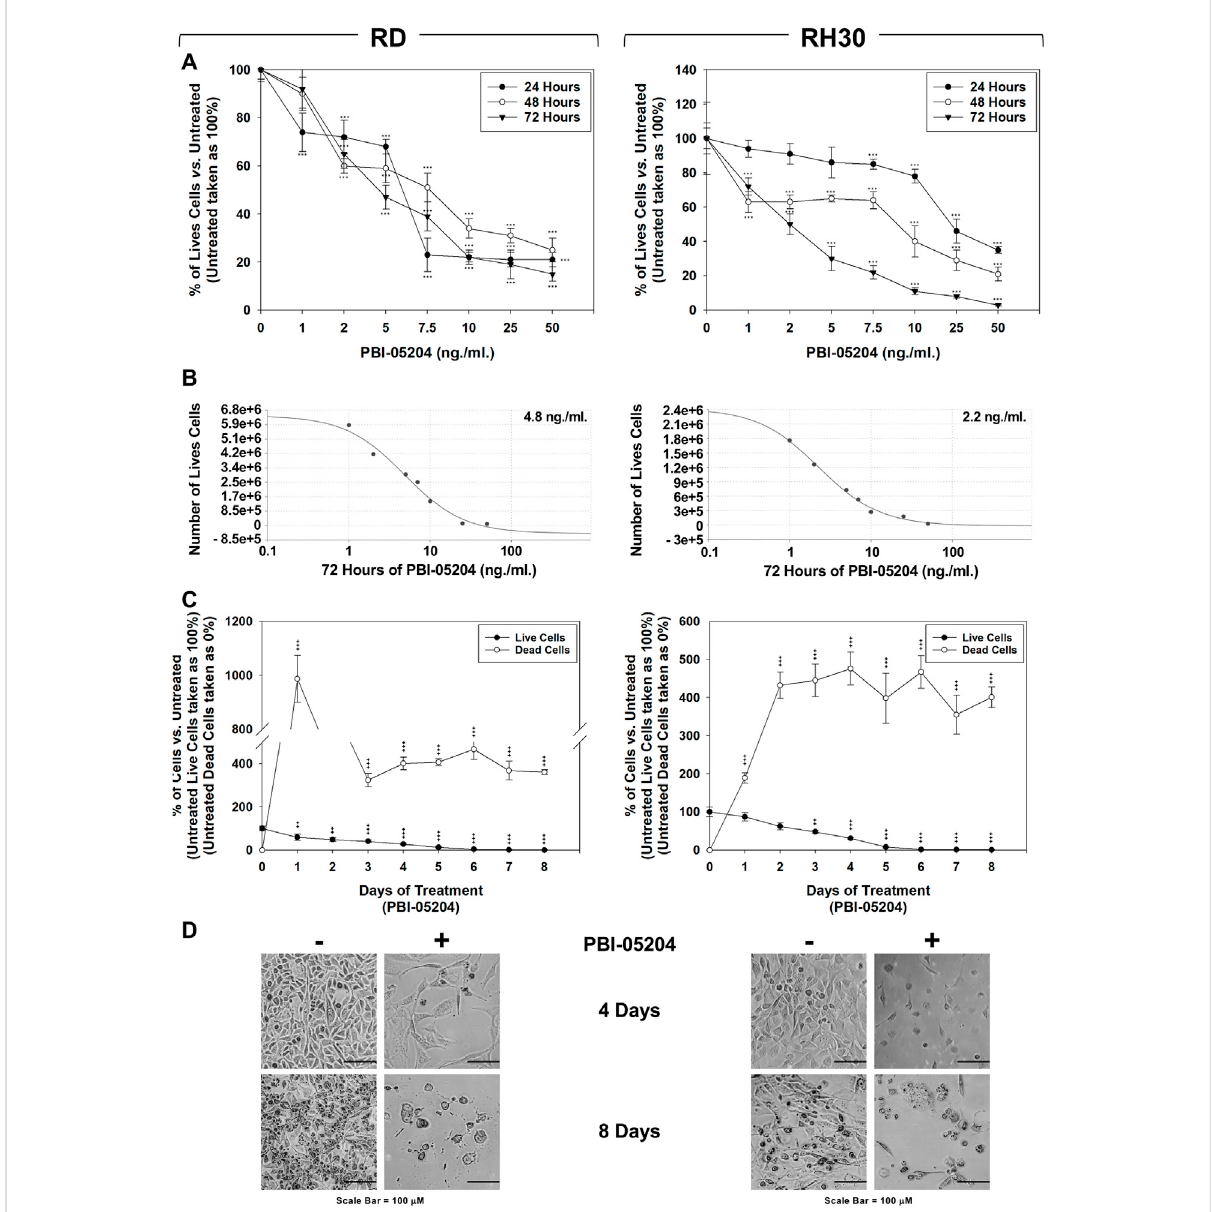
FIGURE 1 PBI-05204inducesconcomitantcelldeathandgrowtharrestinFN-RMSandFP-RMScells.RD(Left)andRH30(Right)celllinesweretreatedfor 24, 48 and 72 h with increasing concentrations (0, 1, 2, 5, 7.5, 10, 25, 50 ng/ml) of the drug. Surviving (A) cells were counted using Trypan blue dye exclusiontest. (B) ConcentrationofPBI-05204abletoreduceby50%thecellsurvivalofRD(Left)andRH30(Right)celllines. (C) EffectofPBI-05204 IC 50 on cell number oflive and dead RD (Left) and RH30 (Right)cells. Surviving cells were counted using Trypanbluedye exclusion test. Results represent the mean values of three independent experiments ±SD. Statistical signi fi cance: * p ≤ 0.05, ** p ≤ 0.01, *** p ≤ 0.001 vs. Untreated. (D) Cellular morphology of RD (Left) and RH30 (Right), untreated or treated with PBI-05204 (IC50) for 4 d was analyzed under light microscope at ×200 magni fi